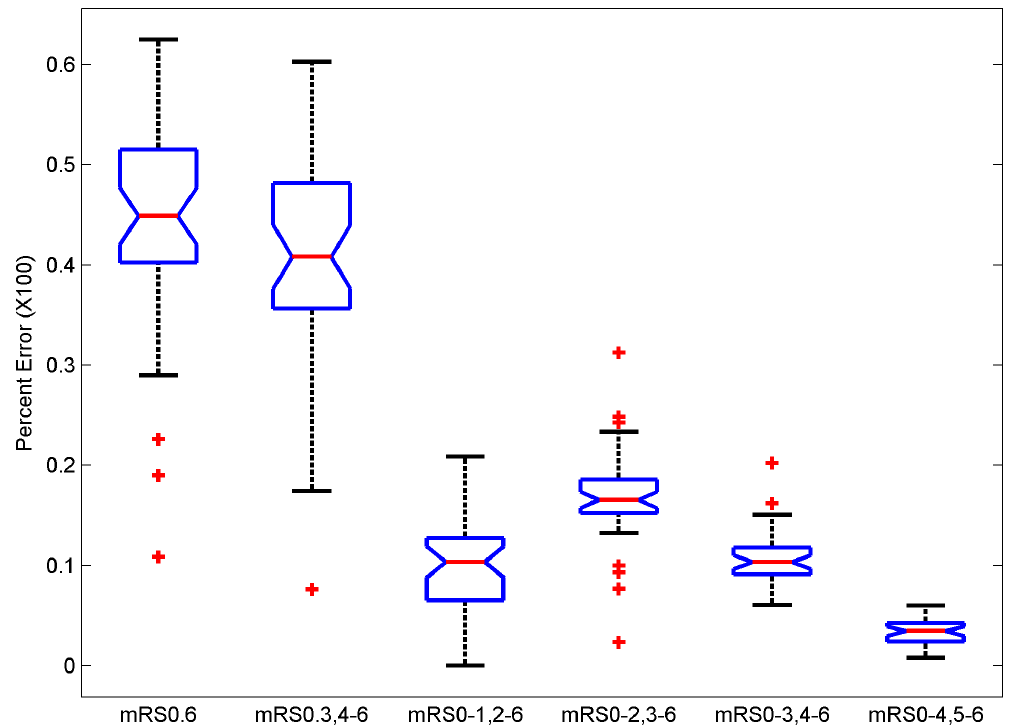
Figure 4. Inter-rater reliability matrix for mRS from Wilson et al [ 26 ] used as confusion matrix. Box plots of error rates for the full ordinal scale of mRS (mRS 0.6), considering mRS 0 to 3 as individual grades and collapsing mRS grades 4 to 6 (mRS 0.3,4–6), dichotomizing at a cut-point of mRS 1 (mRS 0–1, 2–6), dichotomizing at a cut-point of mRS 2 (mRS 0–2, 3–6), mRS 3 (mRS 0–3, 4–6) and mRS 4 (mRS 0–4, 5–6). Post-hoc testing shows that each error rate with this matrix is higher than the corresponding error using van Swieten’s confusion matrix except the error rates for mRS 4.